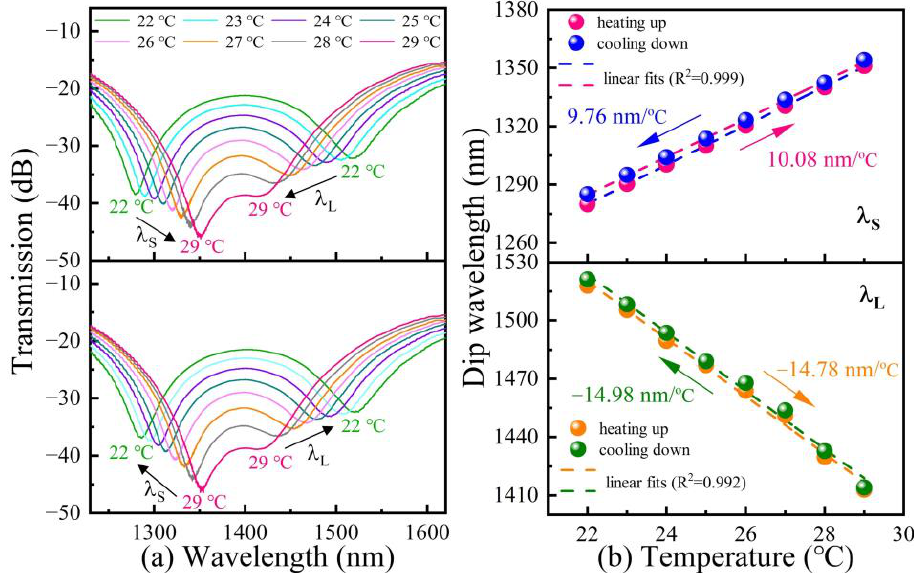
Figure 7. ( a ) Transmission spectra evolutions of the cascaded MZI temperature sensor in the case of temperature cycling from 22 to 29 °C; ( b ) temperature response of the dip wavelengths λ S and λ L in the transmission spectrum of the cascaded MZI temperature sensor.